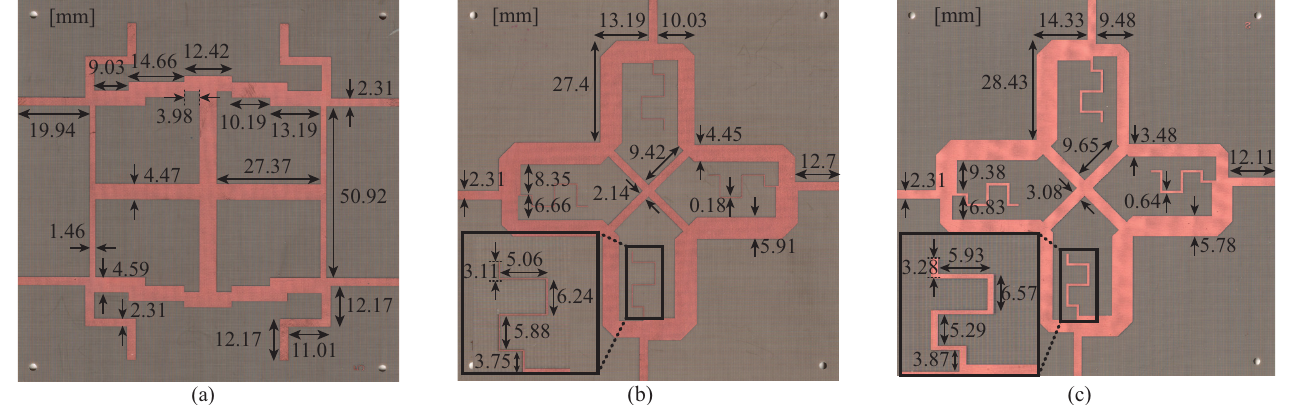
Figure 5. Photographic image of fabricated couplers. ( a ) Coupler A, ( b ) Coupler B, and ( c ) Coupler C.